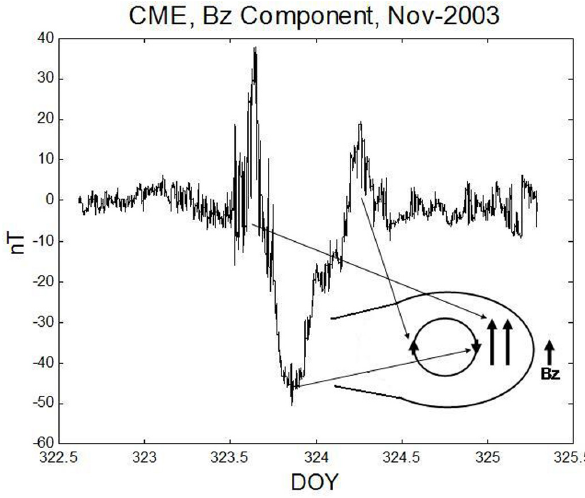
Fig. 6. Schematic approach of the action of the magnetic coherent vortex over IMF- B z